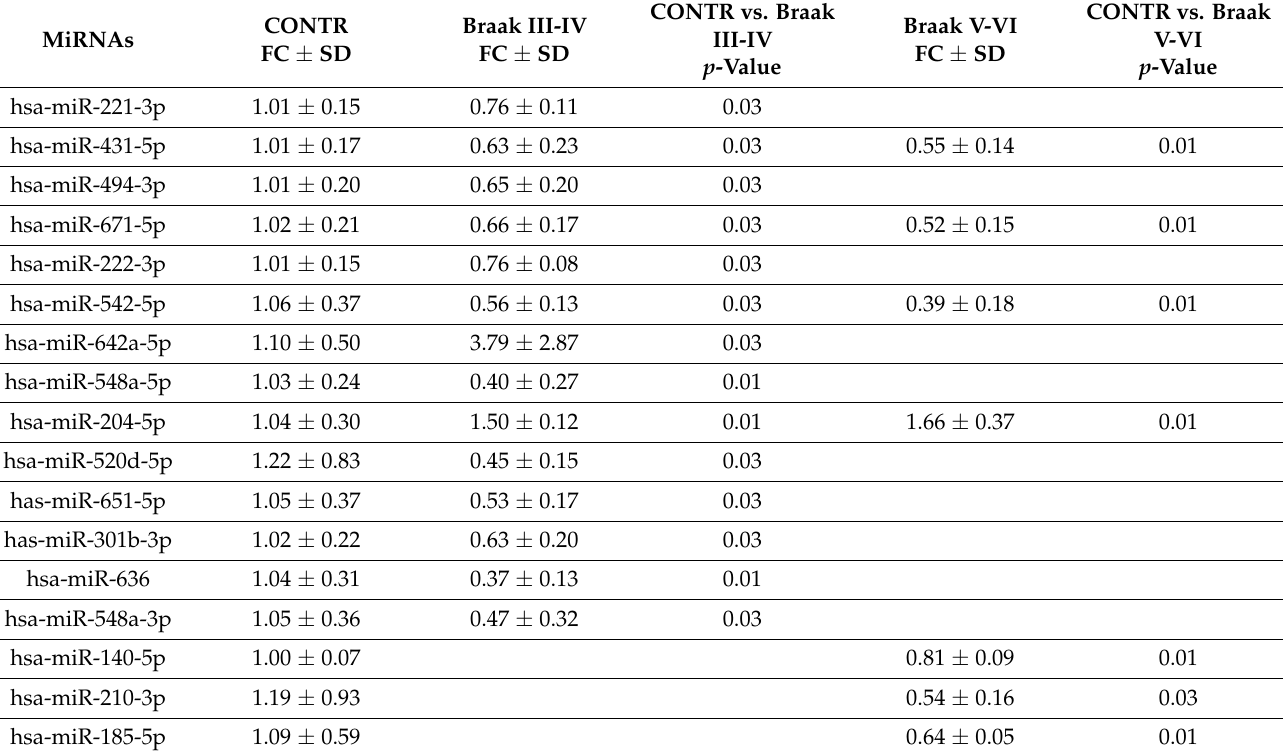
Table 2. DE-miRNA in Braak stage III-IV and Braak stage V-VI compared to controls (Braak stage I-II). Fold changes (FD), standard deviation (SD), and p -values ≤ 0.05 are